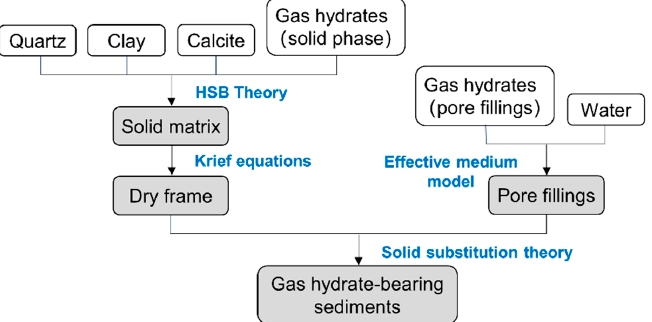
Figure 2. Workflow to construct the rock physics model for sediments containing gas hydrates with various gas hydrate occurrences in Figure 1.